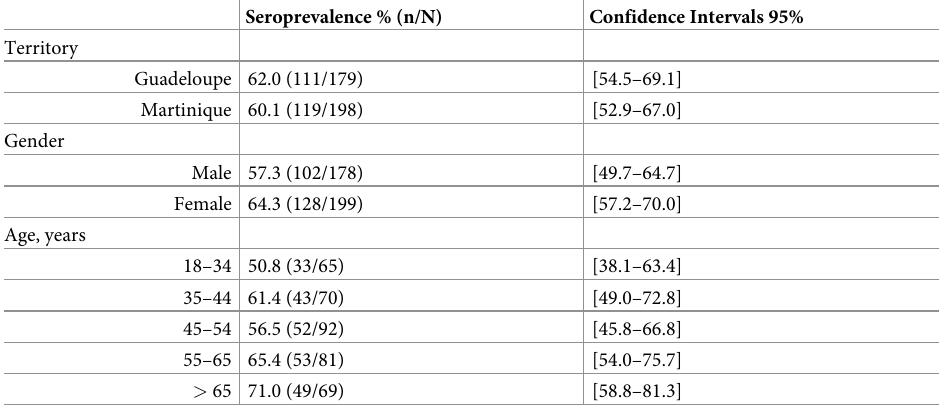
Table 2. Seroprevalence of CHIKV in patients in Martinique and Guadeloupe according to territory, gender, and age (N =